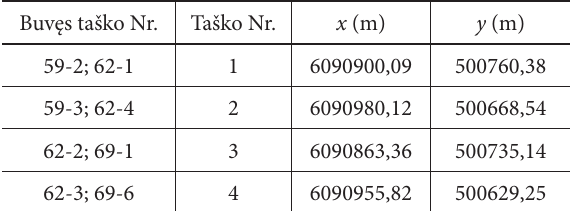
Table 7. The optimized coordinates of the landmarks Buvęs taško Nr. Taško Nr.